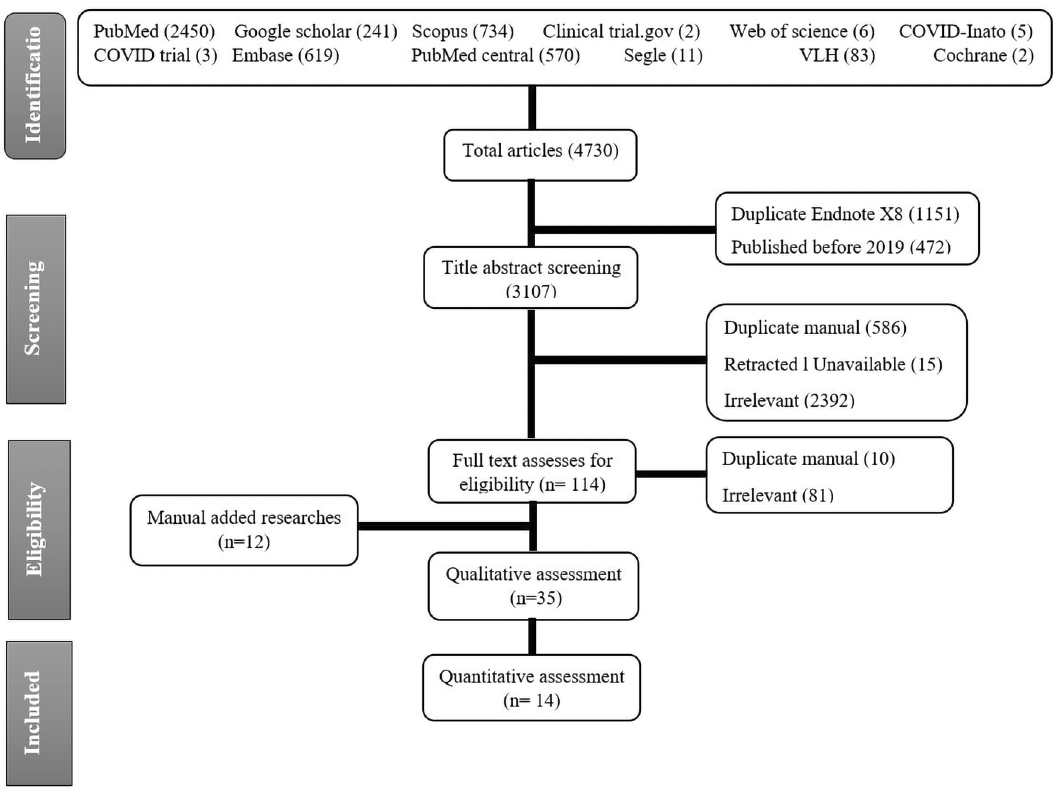
Figure 1. PRISMA flow chart of studies screened and